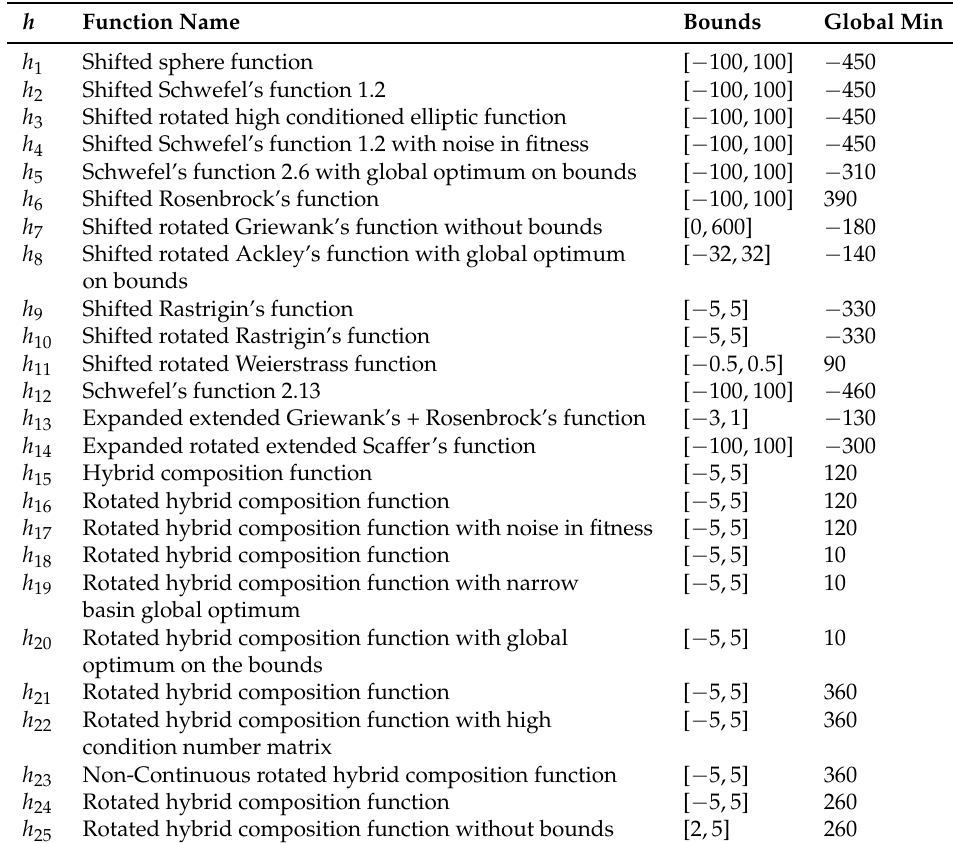
Table A1. Hard Test